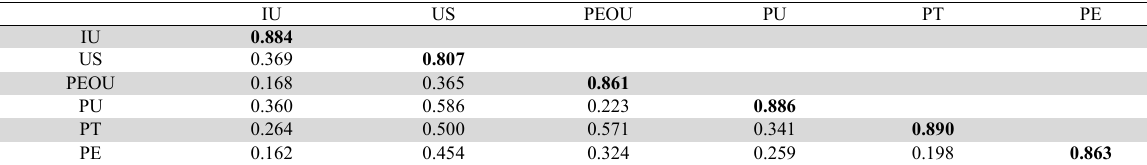
Fornell-Larcker Scale